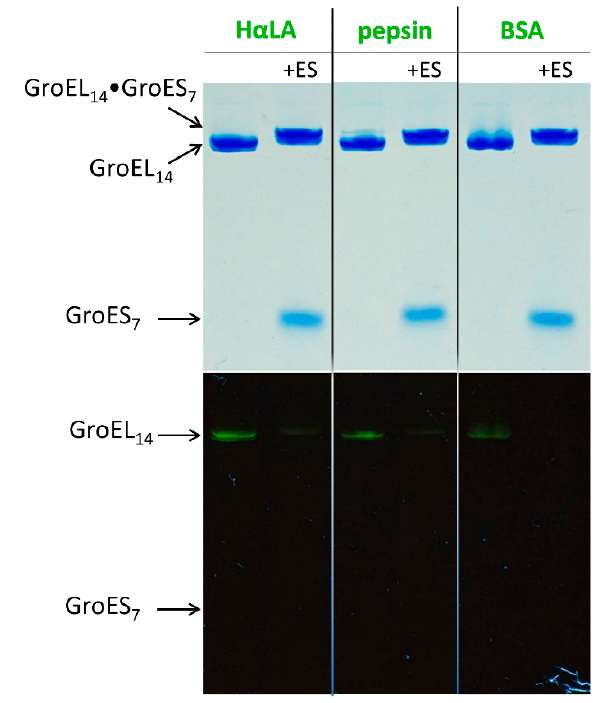
Figure 1. Non-denaturing electrophoresis of the GroEL complex with equimolar fluorescein (FAM)-labeled denatured proteins in the presence of Mg-ADP. In the absence (slot 1) or presence (slot 2) of GroES (two-fold molar excess). Upper part, Coomassie staining; lower part,